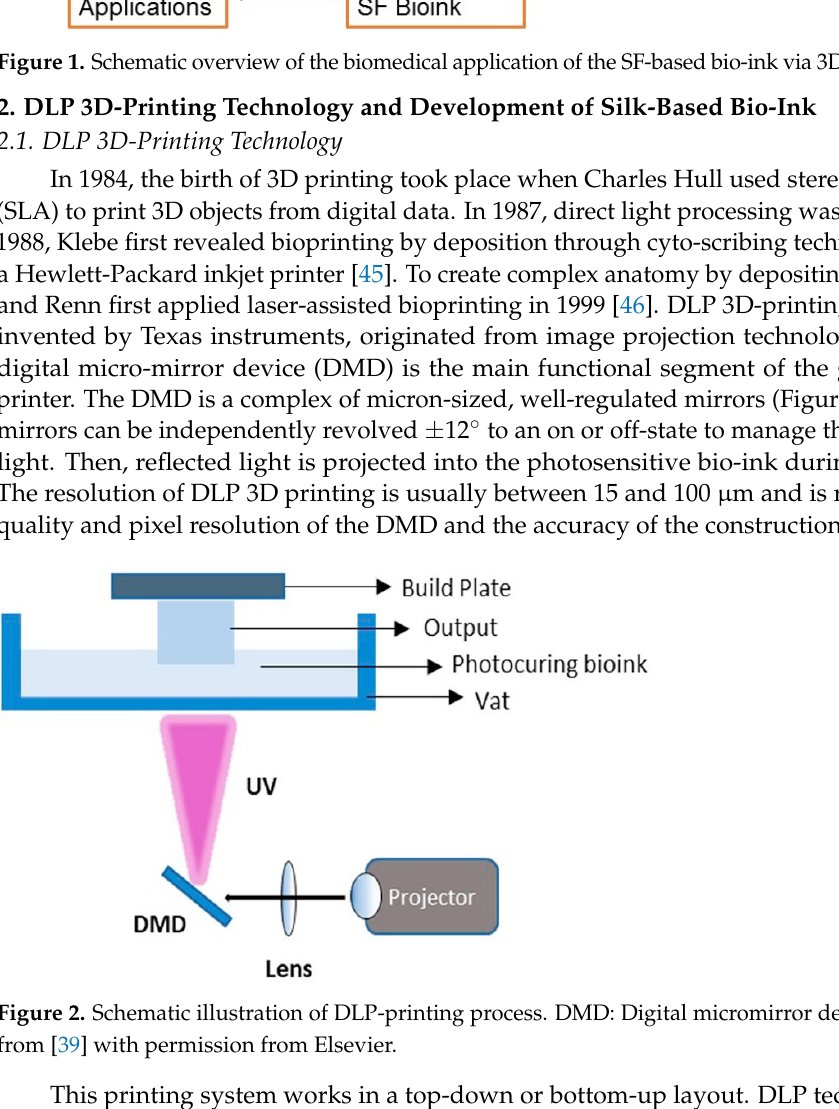
Figure 1. Schematic overview of the biomedical application of the SF-based bio-ink via 3D DLP printing.